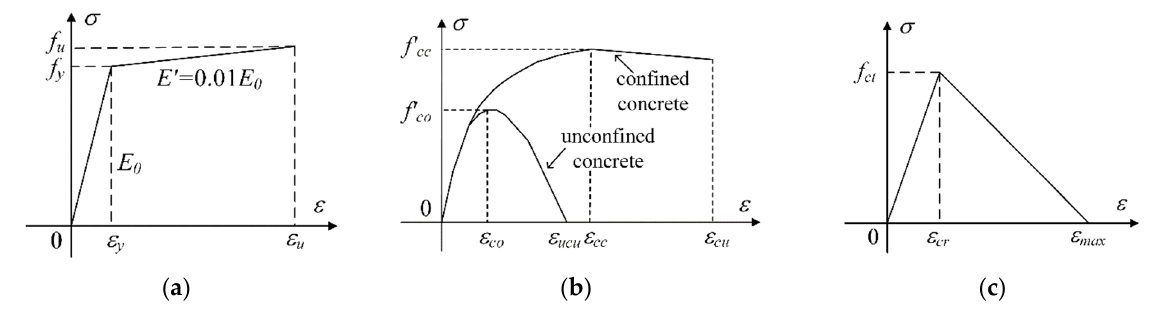
Figure 2. Fiber division of beam and column section: ( a ) beam and ( b ) column.